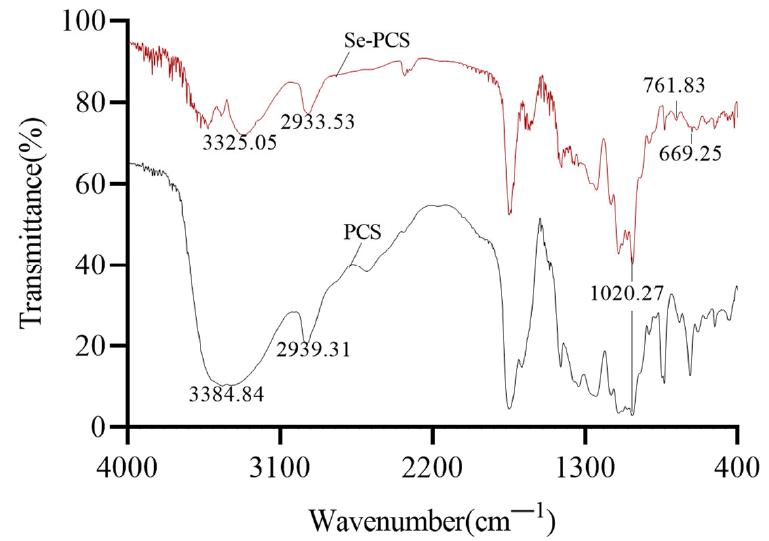
Figure 2. The infrared spectra scanning of Se-PCS and PCS.